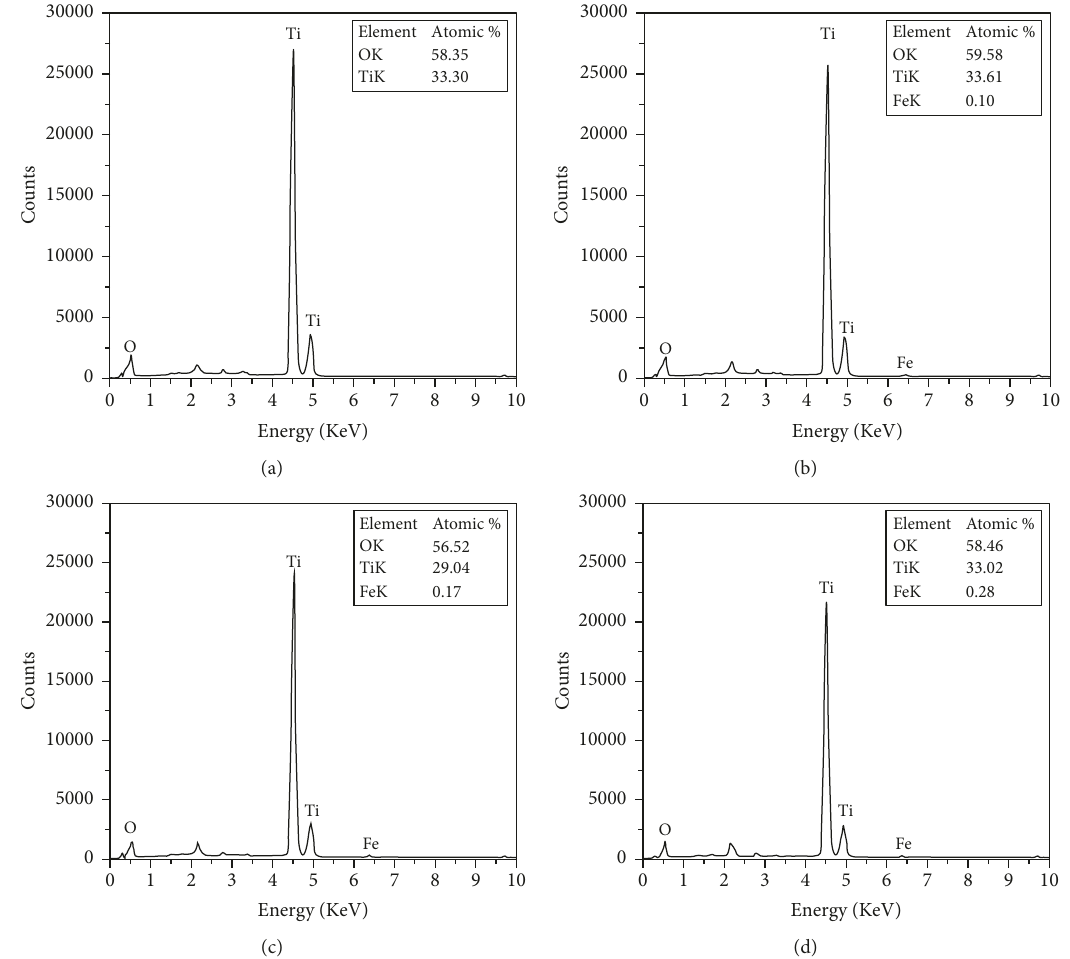
Figure 6: EDS patterns of Fe TiO 2 Nanoparticles at different pH values (a) pH (cid:31) 2, (b) pH (cid:31) 4, (c) pH (cid:31) 5, and (d) pH (cid:31)